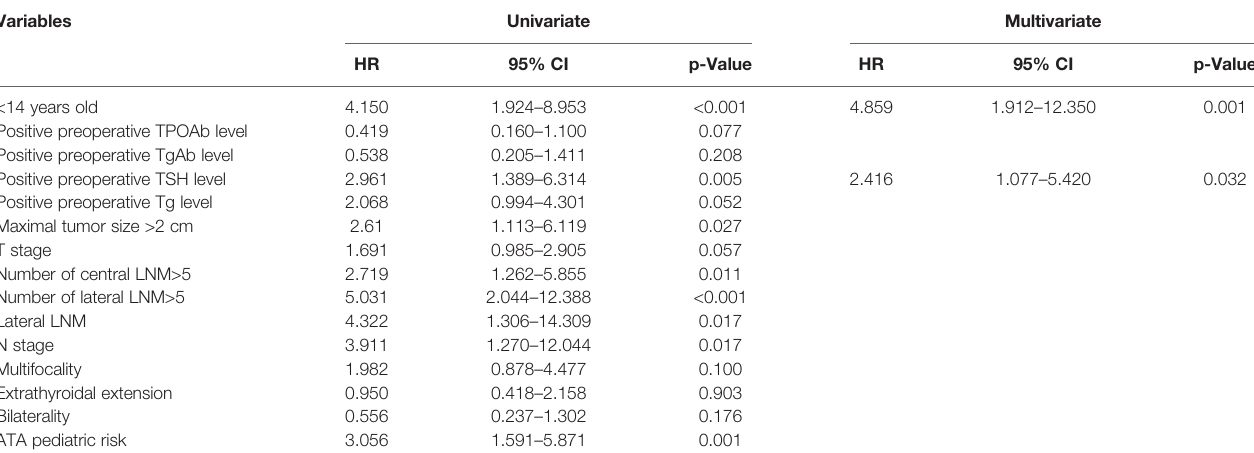
TABLE 5 | Cox proportional hazards regression analysis for variables associated with PTC